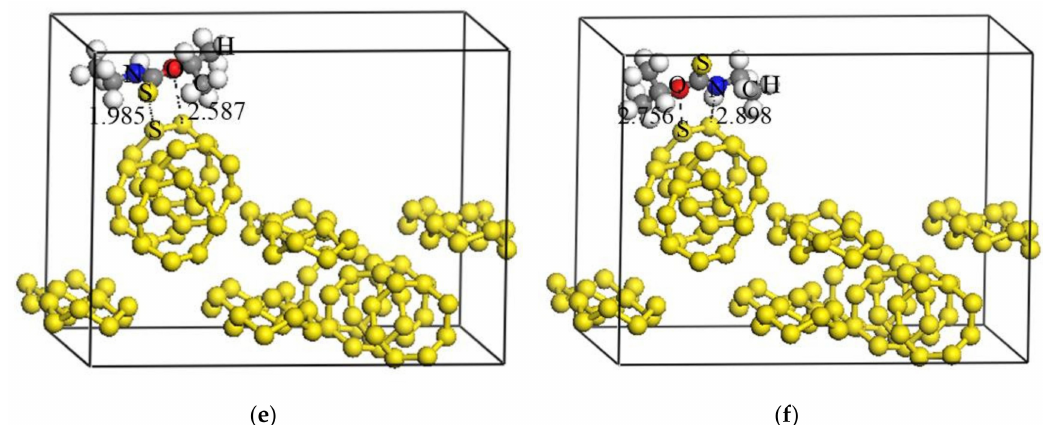
Figure 9. Adsorption configurations of IPETC on perfect elemental sulfur (100) crystal plane (( a ) adsorption of carbonyl S atom; ( b ) adsorption of N atom; ( c ) adsorption of O atom; ( d ) adsorption of carbonyl S together with N atoms; ( e ) adsorption of carbonyl S together with O atoms; ( f ) adsorption of N together with O atoms). Table 10. Adsorption energy of each adsorption configuration of IPETC on elemental sulfur (110) crystal plane.